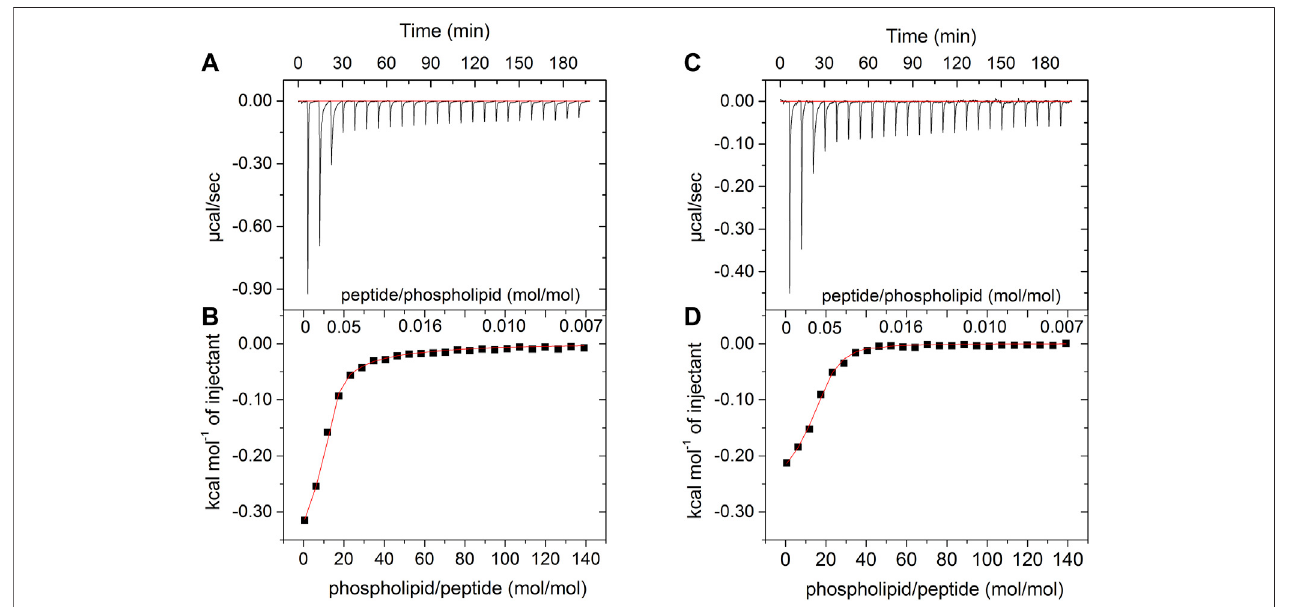
FIGURE 2 | Calorimetric titration isotherms obtained from the titration of 25 μ M solution of (A,B) LyeTxI-b and (C,D) LyeTxI, with 20 mM LUVs POPC:POPG (3:1, mol:mol). (A) and (C) panels show heat fl ow graphs for each LUVs injection as a function of time. (B) and (D) panels show the enthalpy as a function of phospholipid/ peptide molar ratio for each titration and the red curves consist in the regression line generated by fi tting the isotherm to a single-site peptide-membrane interaction model, according to Eq. 2 (see item Isothermal Titration Calorimetry section).